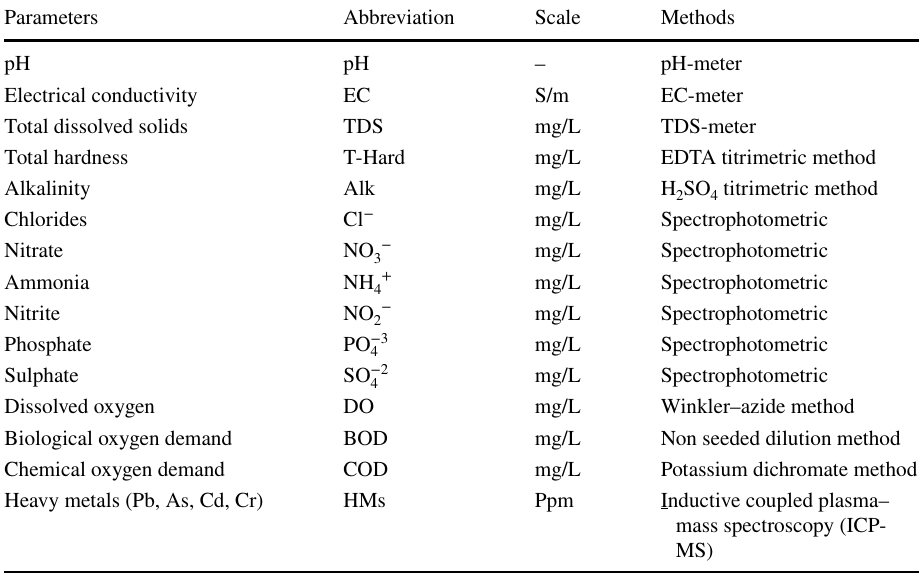
Table 1 Physiochemical parameters of water with their units and methods of